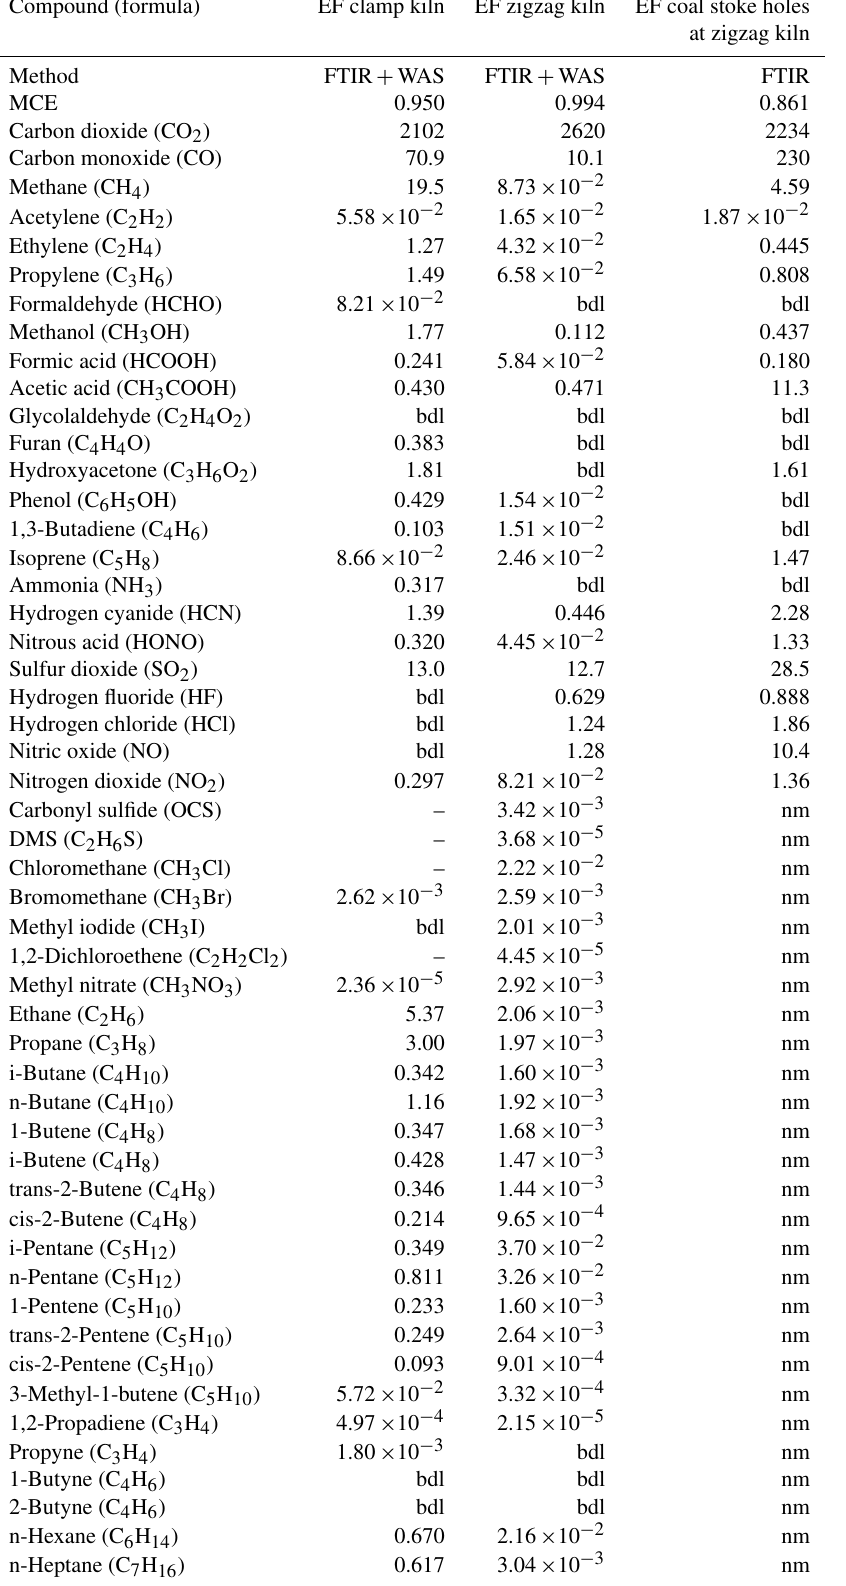
Table 6. Emission factors (gkg − 1 ) for a single clamp kiln, zigzag kiln, and stoke holes on the zigzag